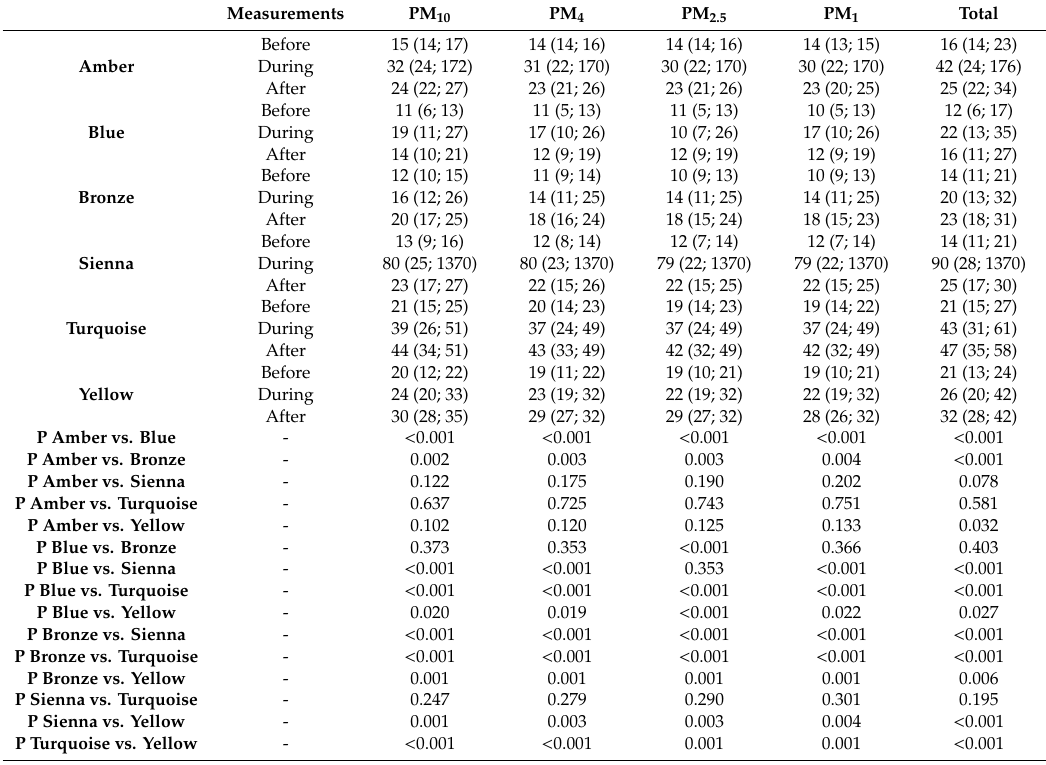
Table 3. Levels of particulate matter (PM), expressed as µ g / m 3 , comparing di ff erent flavors of Iqos *. Measurements